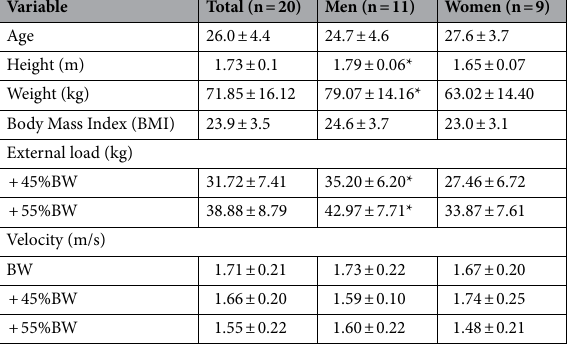
Table 1. Participant characteristics (mean ± SD). * Men significantly ( p ≤ 0.05) greater than women.